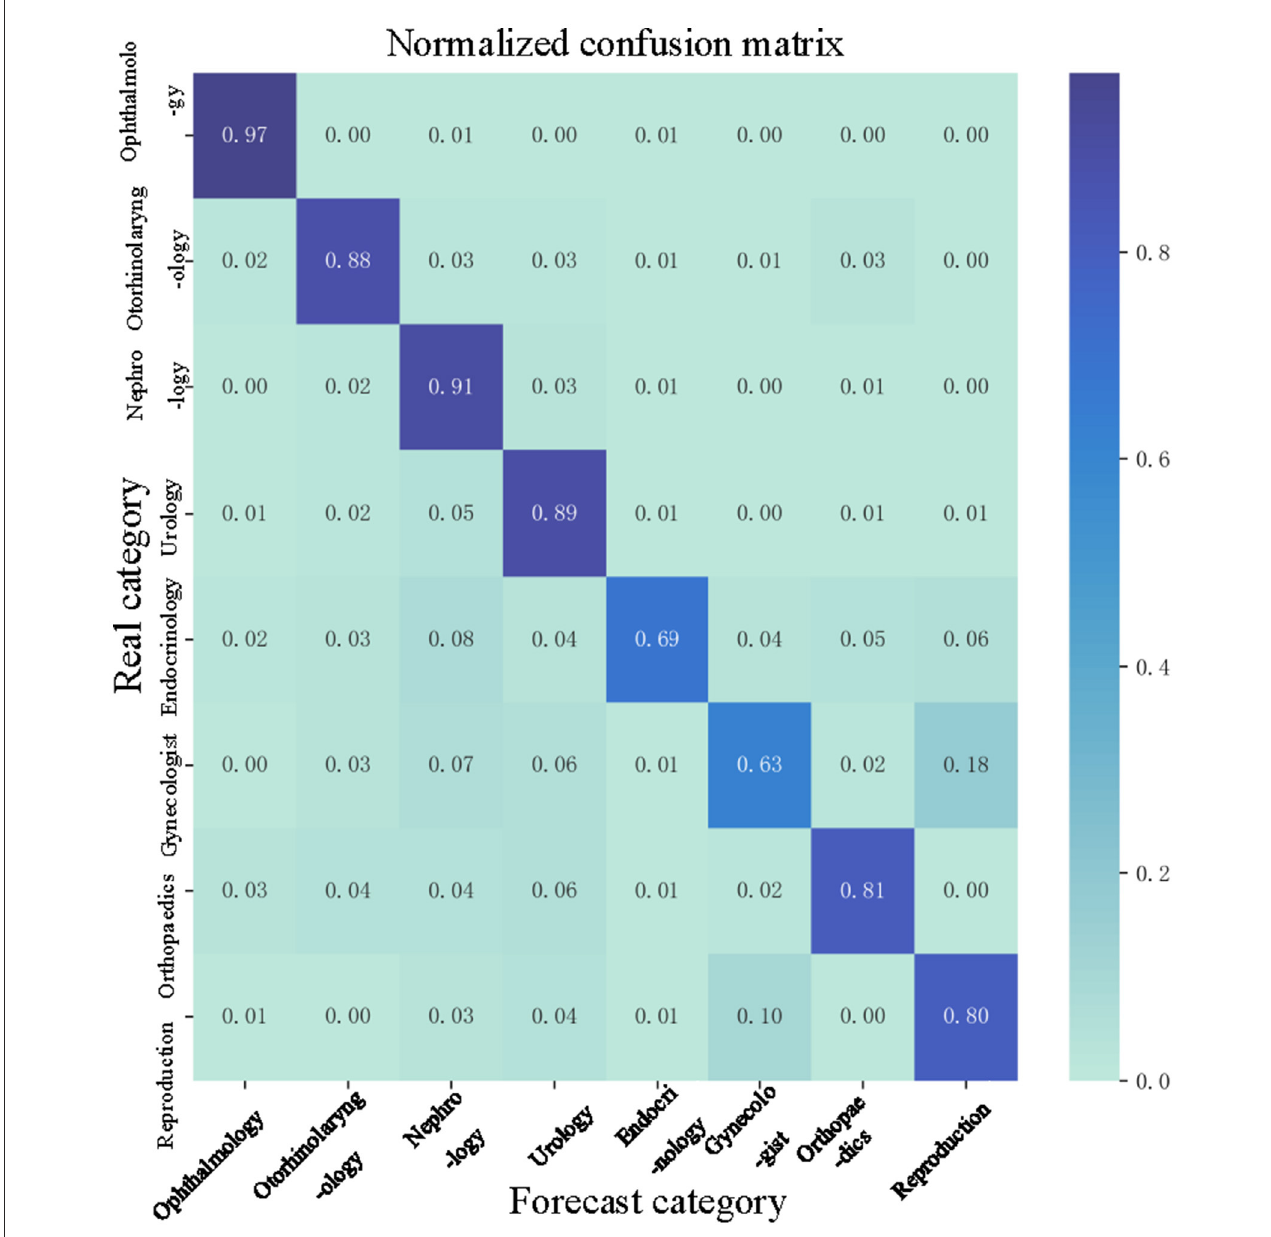
FIGURE9 Normalized confusion